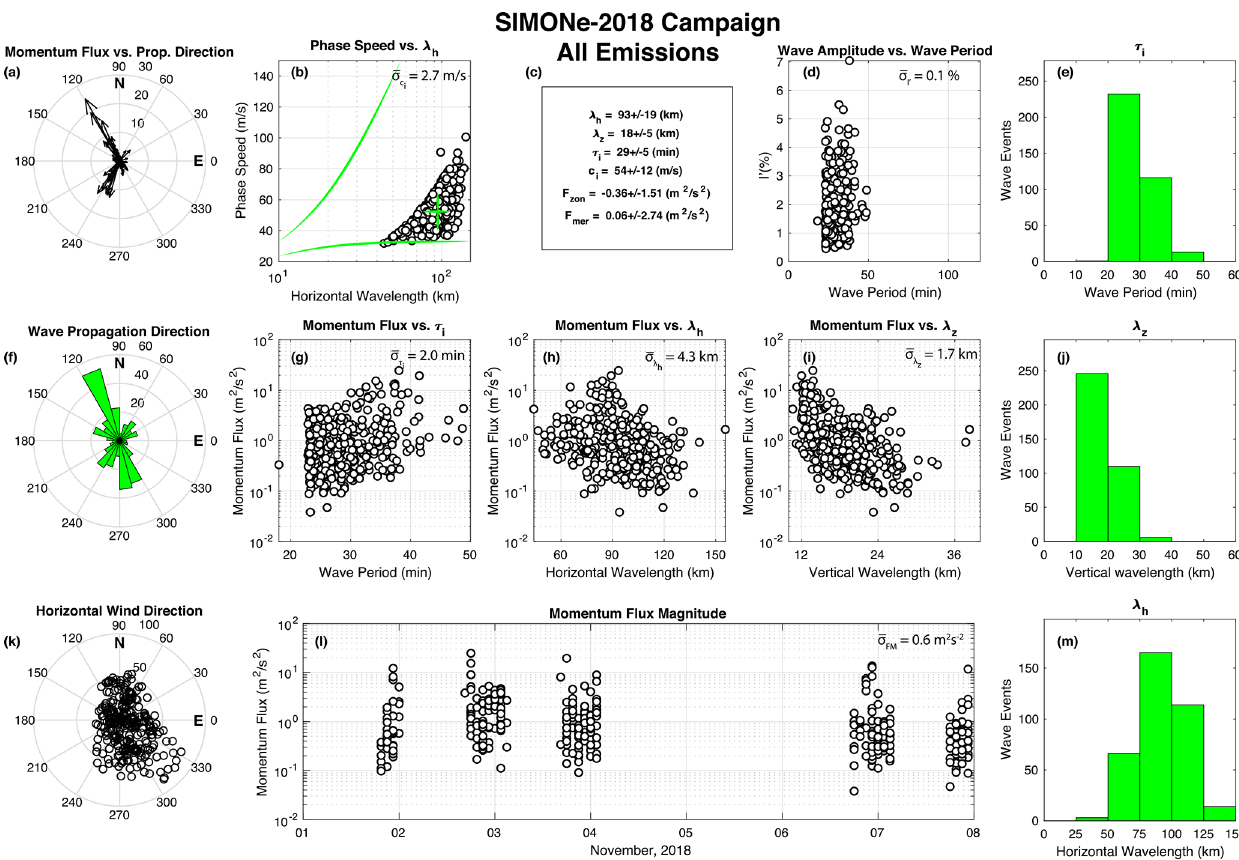
Figure 5. Short-period wave parameters obtained from OH, O 2 , O( 1 S), and Na airglow image analysis using the auto-detection method (Tang et al., 2005; Vargas et al., 2009; Vargas, 2019). The mean measurement error is indicated in the chart of each wave parameter. Plots of waves detected in each emission separately are in the Supplement of this